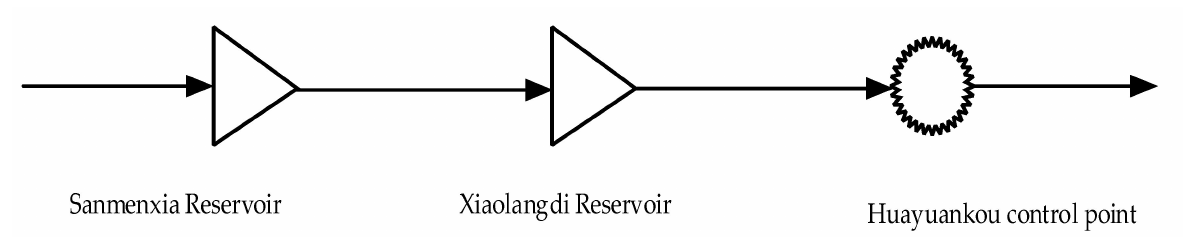
Figure 4. Location of Sanmenxia, Xiaolangdi Reservoir and